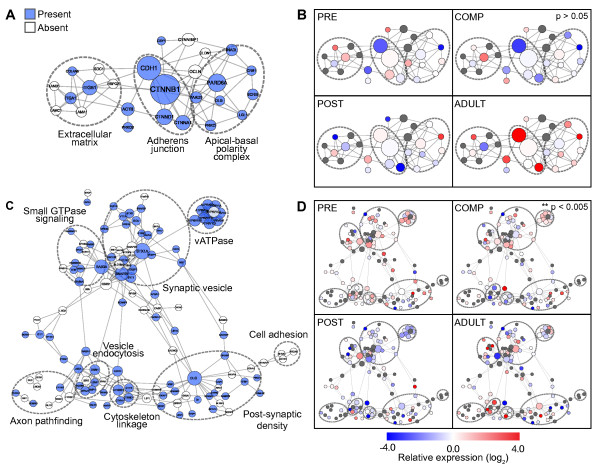
Expression of epithelial and synaptic gene homologs. Interaction network of epithelial (A) and synaptic (C) genes showing homologs that are present in the A. queenslandica genome (blue circles). Genes with related functions are indicated by dotted circles. Sponge genes were retrieved by matching Aqu1 gene models to previously published sequences [23,69]. Protein interactions were obtained from STRING [70] and displayed using Cytoscape [71]. Relative expression of epithelial (B) and synaptic (D) gene homologs in the four developmental stages (red, high; blue, low; gray, no sponge homolog). Stage enrichment of genes was estimated using Fisher’s exact test (p-values shown).